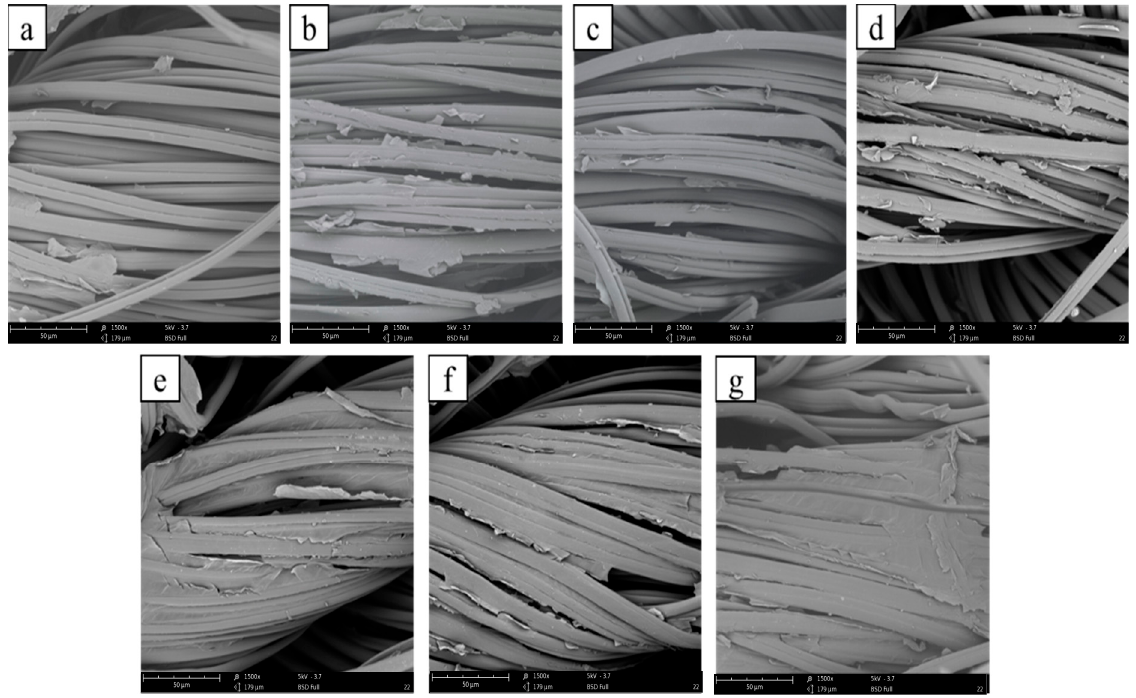
Figure 1. SEM images of conductive graphene fabric soaked 1–7 times (1500×, ( a – g ) were soaked 1–7 times respectively).